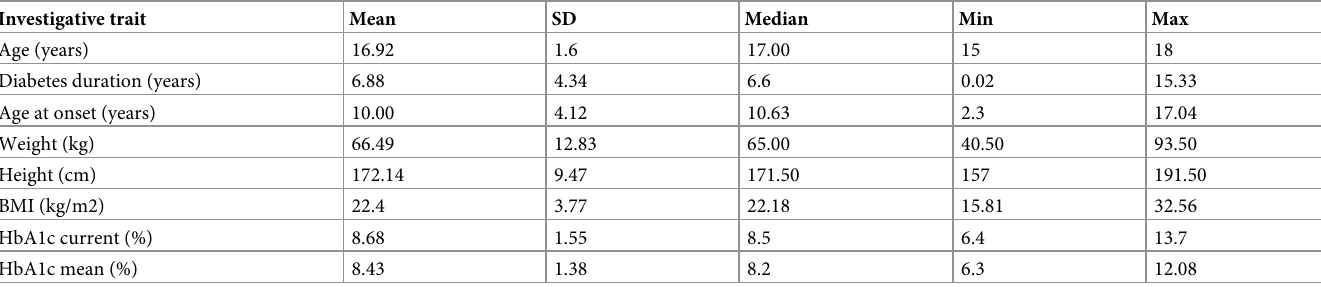
Table 1. Characteristics of the patients with type 1